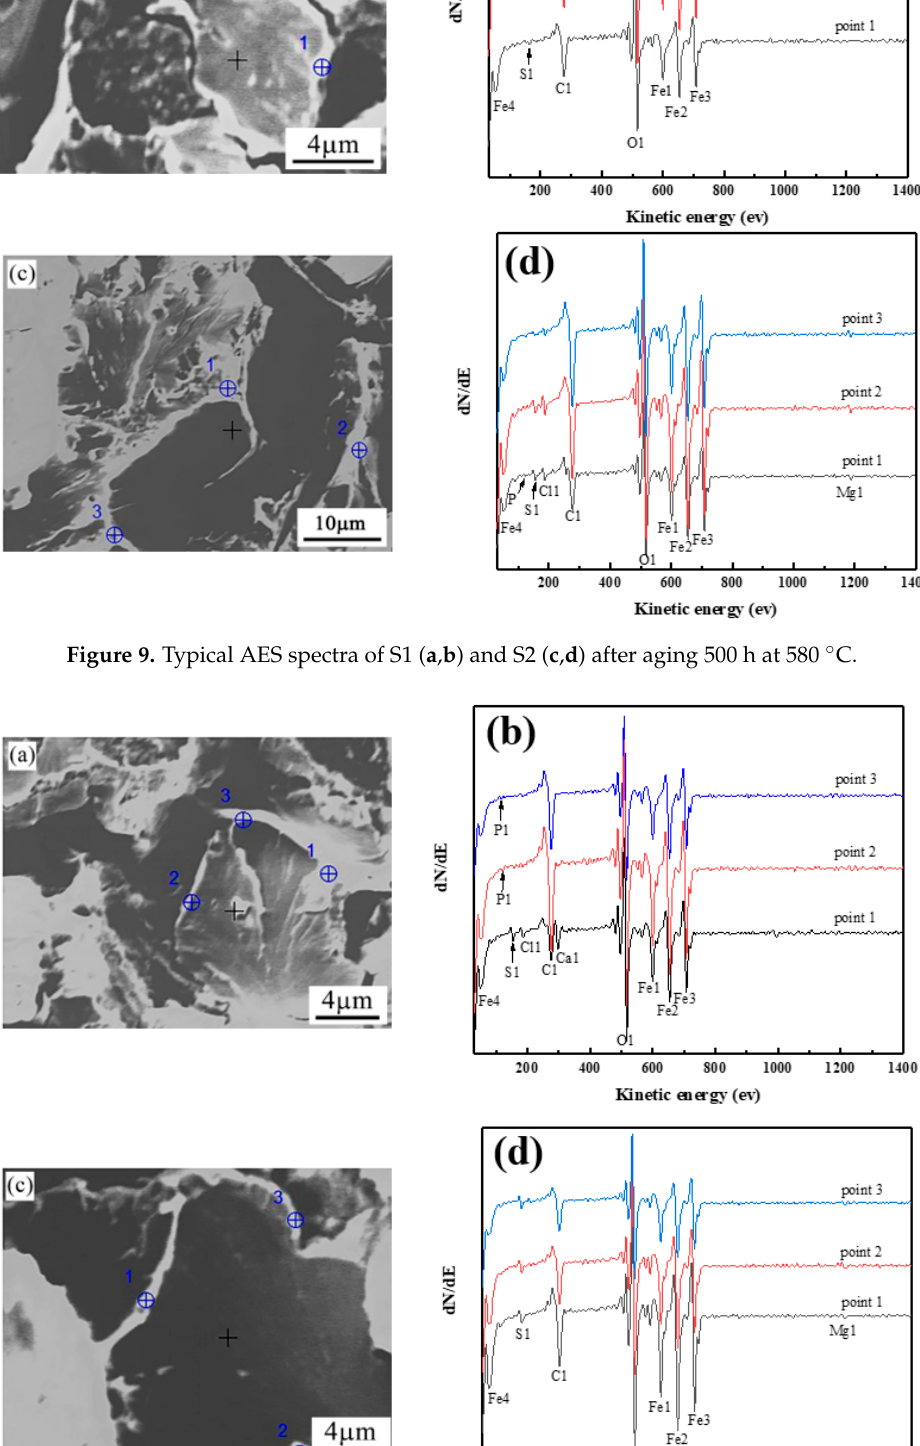
Figure 10. Typical AES spectra of S1 ( a , b ) and S2 ( c , d ) after aging 5000 h at 580 °C. As can be seen in Table 3, P and S peaks are not detected at the grain boundary in S1 sample before aging, but when the aging time increases to 500 h, P and S segregation peaks